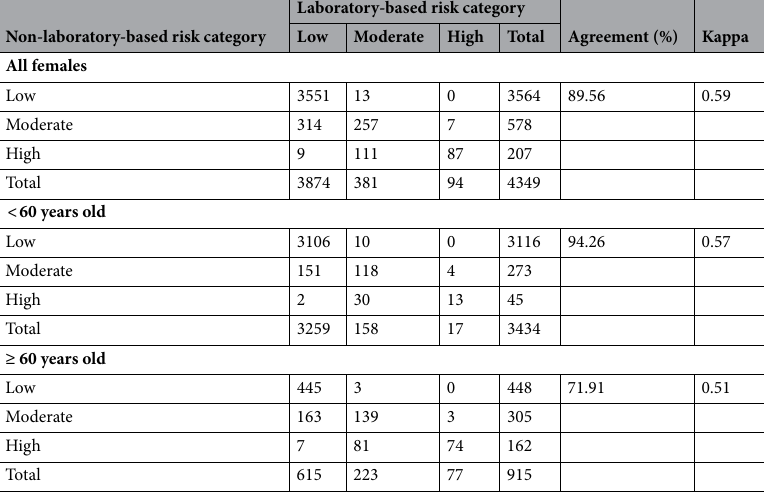
Non-laboratory-based risk